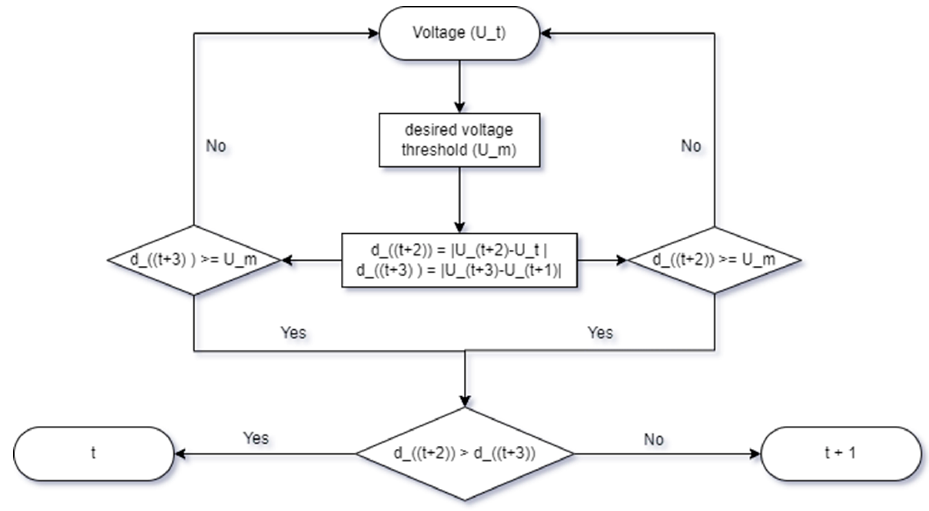
Figure 3. Line plot of voltage rise.